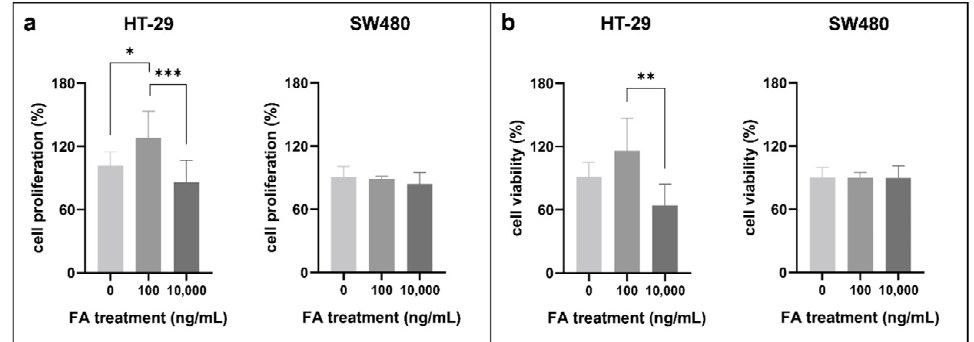
Figure 1. ( a ) Cell proliferation and ( b ) cell viability alterations of HT-29 and SW480 colorectal cancer cell lines following different folic acid (FA) supplies. Sulforhodamine B (SRB) was used for cell proliferation detection (* p ≤ 0.05, *** p ≤ 0.001), while cell viability data were obtained by alamarBlue assay (** p ≤ 0.01). FA-depleted cells were kept in media containing 0 ng/mL FA, whereas treated cells were exposed to 100 and 10,000 ng/mL FA for 72 h. The percentages of cell proliferation and viability were given relative to samples kept in the normal growth media. FA: folic acid.